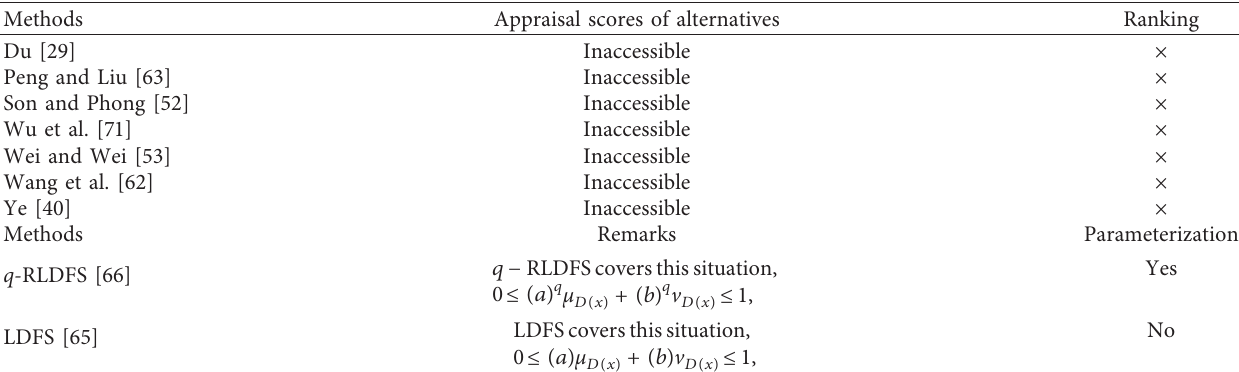
Figure 2: The ranking of the alternative given in Table 3. Table 4: Different methods and their